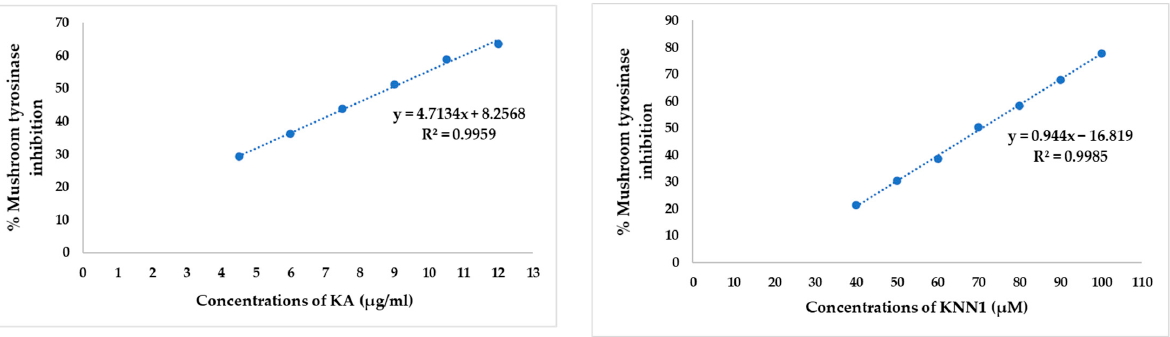
Figure 2. The inhibitory effect of kojic acid ( A ) and hdTIP (KNN1) ( B ) against diphenolase activity of mushroom tyrosinase.